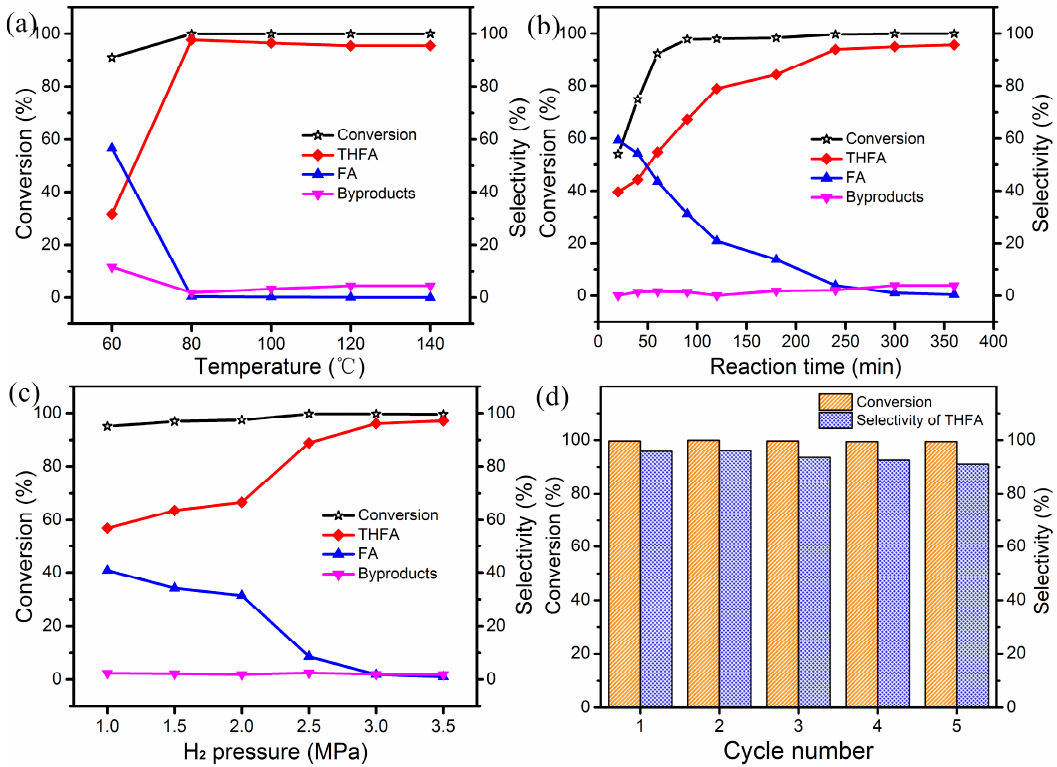
Figure 7. ( a ) effect of reaction temperature: 3 MPa, 5 h; ( b ) effect of reaction time: 80 °C, 3 MPa; ( c ) effect of reaction H 2 pressure: 80 °C, 4 h; ( d ) the reusability of catalyst: 80 °C, 3 MPa, 4 h; other reaction conditions: 0.6 g FFR, 50 mL ethanol, 0.1 g catalyst: Ni/C-400.